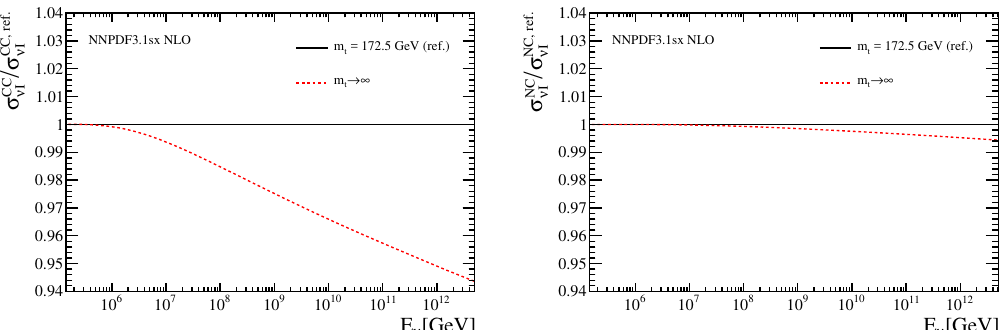
Figure 5 . The ratio of the CC (left) and NC (right) neutrino-isoscalar cross-section at NLO computed in the m t limit compared with our default (ref.) n f = 6 FONLL calculation with ! 1 m t = 172 : 5